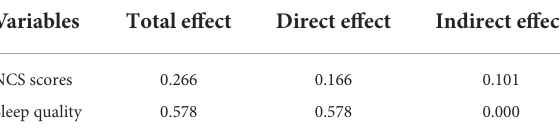
TABLE 6 Mediating effect of sleep quality between negative coping style and psychological distress among psychiatric nurses ( n = 812, Shandong,